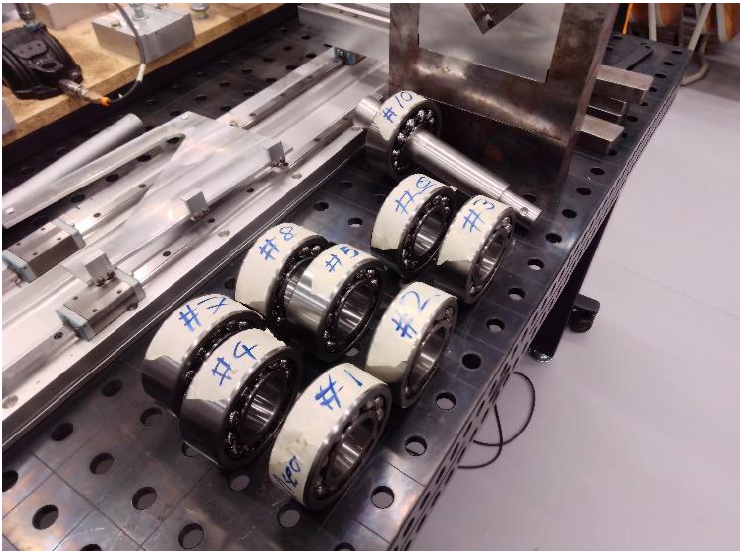
Figure 9. Bearings studied in the experiment.